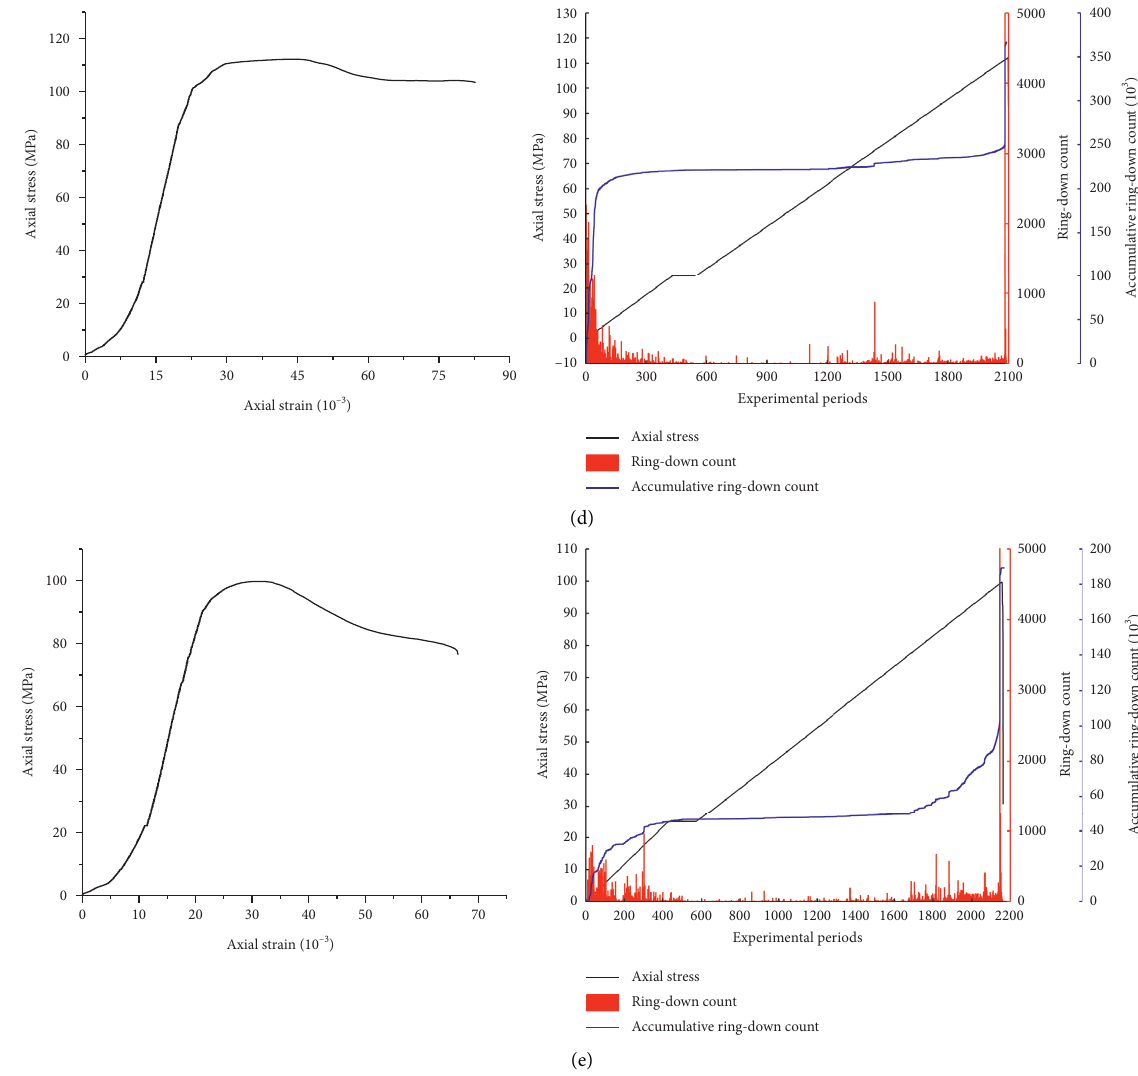
Figure 10: Stress-strain curves under different protective layer mining modes. (a) Initial confining pressure of 15MPa for soft rock protective layer mining. (b) Initial confining pressure of 15 MPa for coal seam protective layer mining. (c) Initial confining pressure of 20MPa for soft rock protective layer mining. (d) Initial confining pressure of 25MPa for soft rock protective layer mining. (e) Initial confining pressure of 25MPa for coal seam protective layer